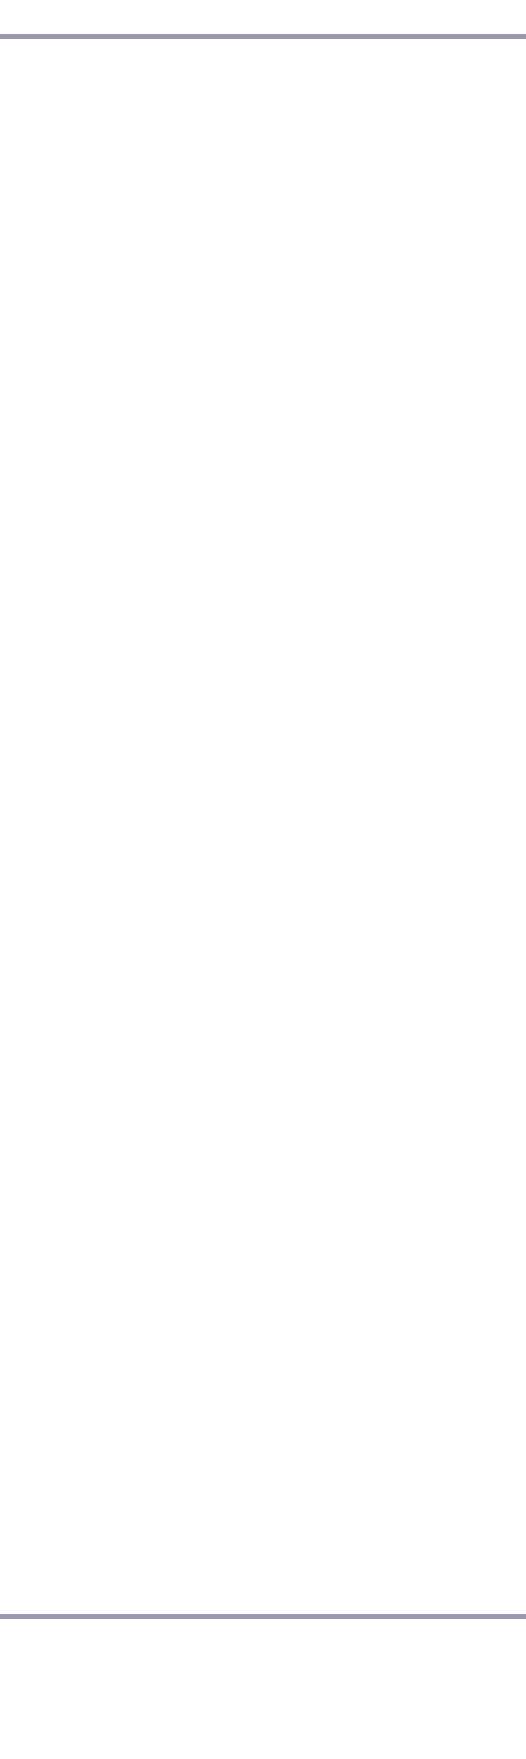
Fig. 1. Example of the lottery ticket